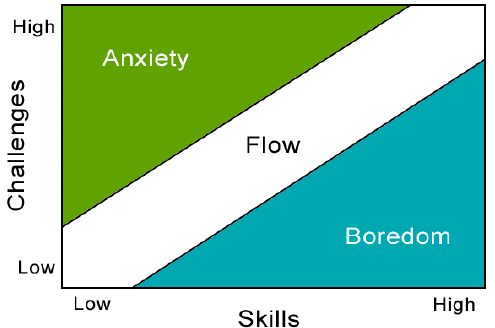
Figure 6. The Flow Channel (Csikszentmihalyi 1990, p. 74).